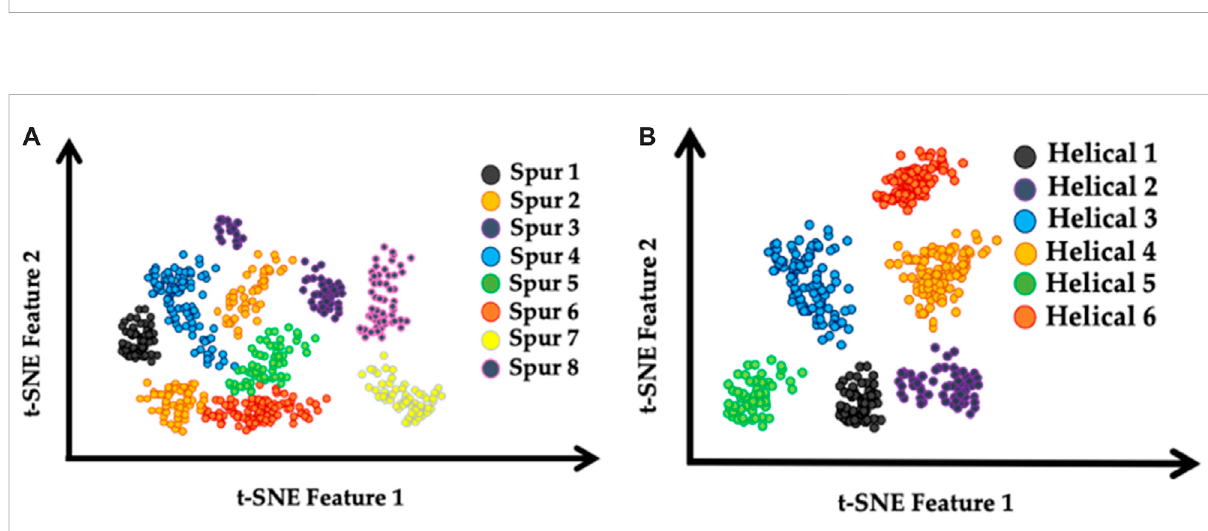
FIGURE 5 The proposed framework of multitask learning based convolutional neural network for simultaneous identi fi cation of faults in multiple gears under uneven load and speed conditions.